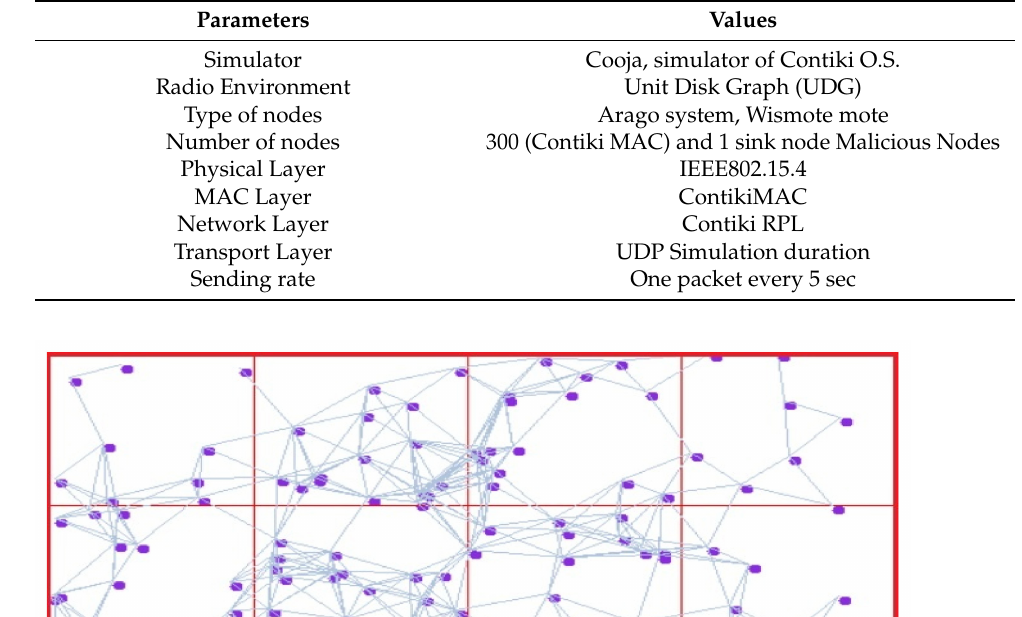
Table 8. Simulation parameters.